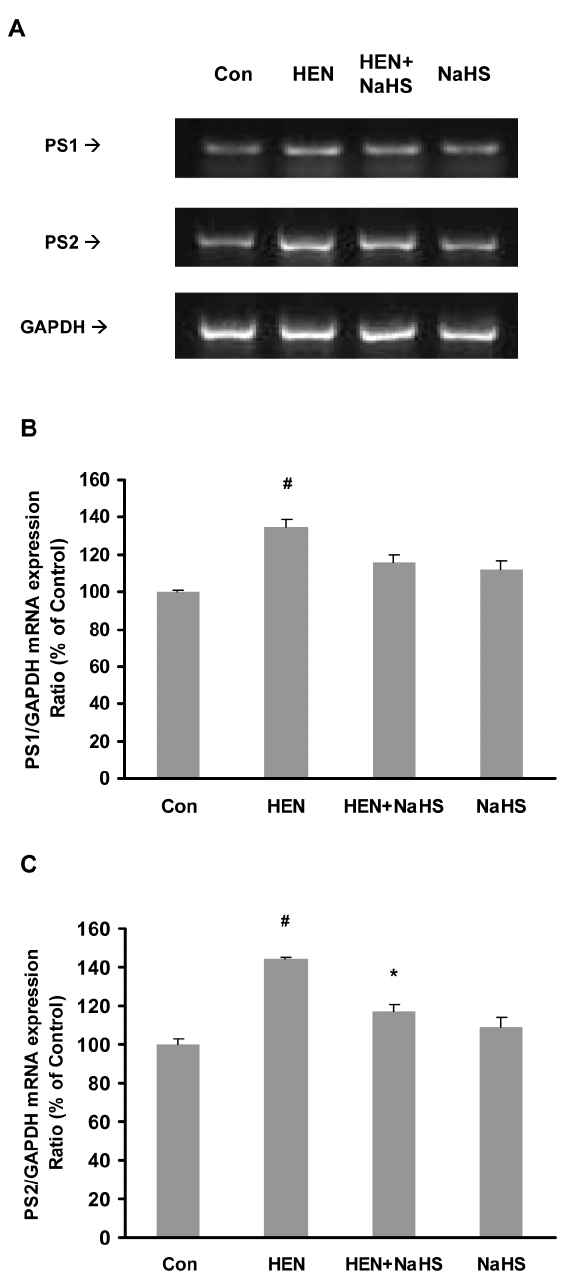
Figure 8. Effect of NaHS on mRNA expressions of presenilins 1 and 2. Representative gels (A) and histograms (B–C) demonstrating the effect of pretreatment with NaHS (100 m M, 12 hours) on HENECA (100 nM, 24 hours) stimulated mRNA expression of presenilins 1 and 2 respectively. Control values were adjusted to 100% for mRNA expression. Data are given as means 6 S.E.M, n=4. # p , 0.05 vs Con group; * p , 0.05 vs HEN group. Con, control; HEN, HENECA. doi:10.1371/journal.pone.0088508.g008 c -secretase activity in the membrane fractions of SH-SY5Y cells was also measured. As shown in Fig 7C, HENECA significantly stimulated c -secretase activity. Treatment with NaHS or DAPT, a